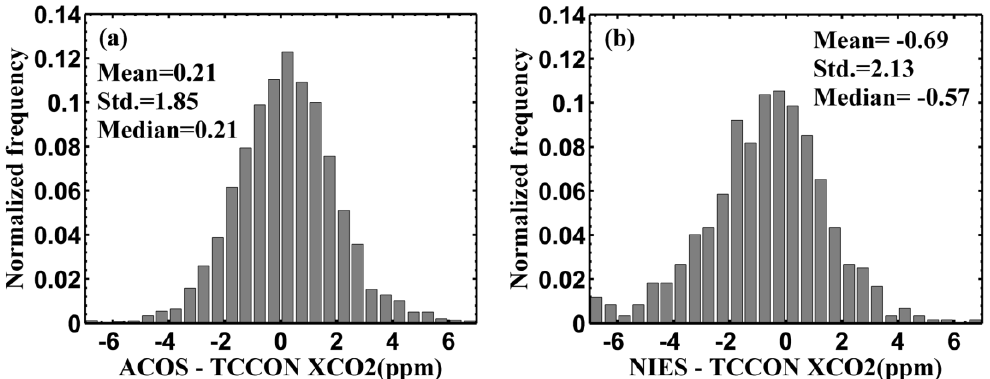
Figure 2. Histogram of the difference of ACOS relative to TCCON ( a ) and NIES relative to TCCON ( b ) for all TCCON sites listed in Table 1.